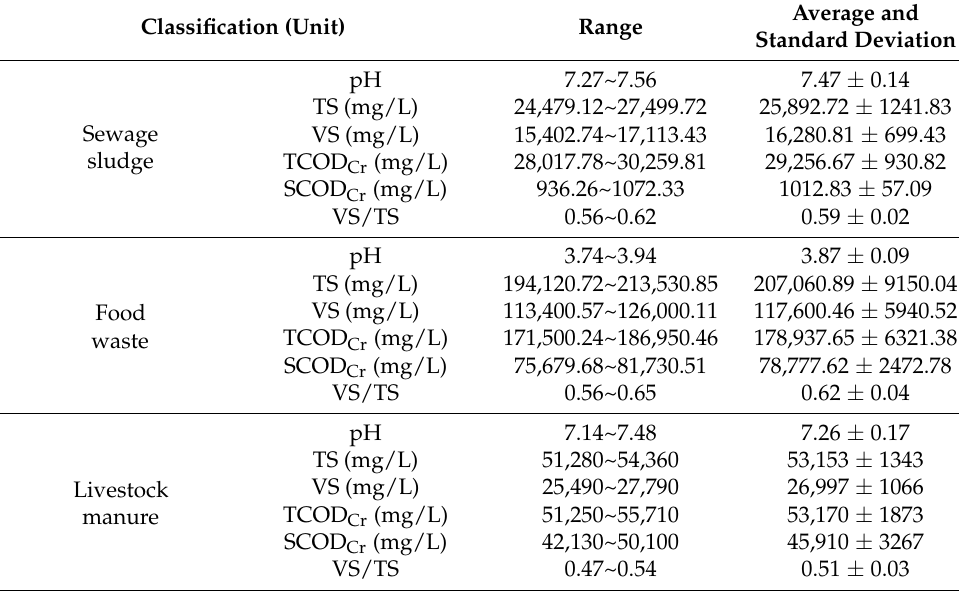
Table 2. Main properties of the substrates used in this